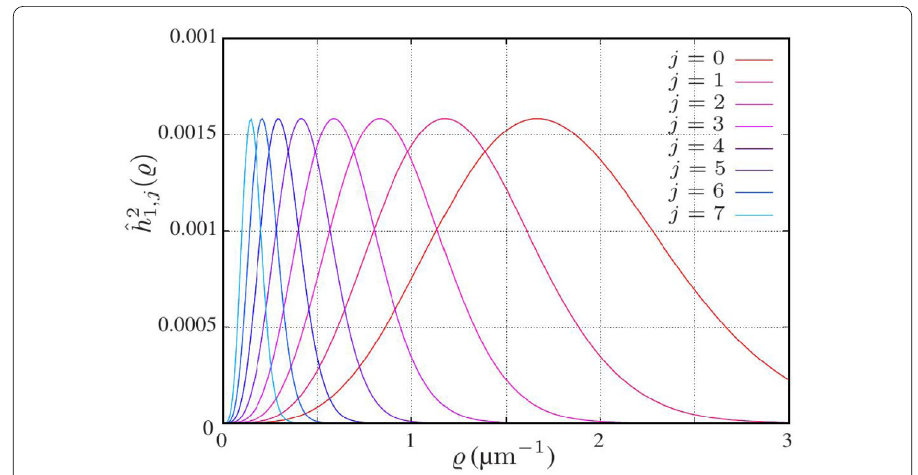
Figure 17 The square ˆ h 2 1, j ( (cid:7) ) of the transfer function of the DoG filter for j = 0, ... ,7